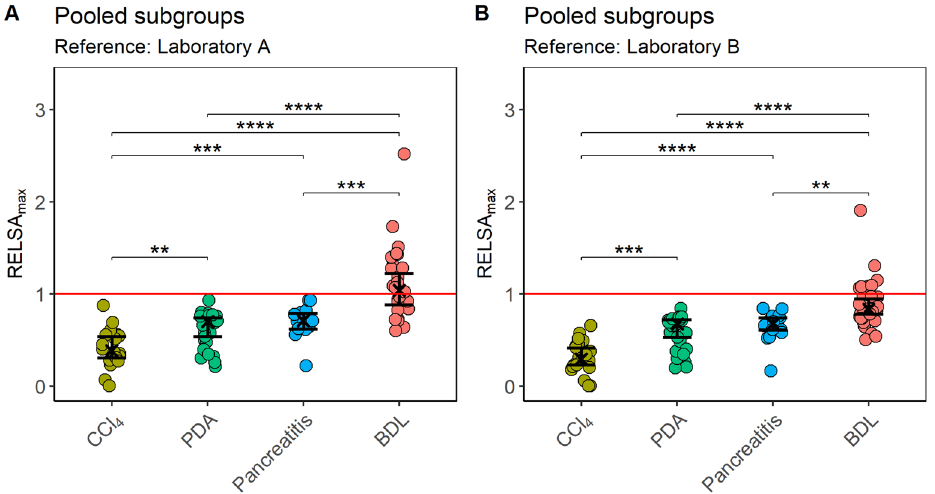
Figure 6. Between-model comparisons of distress after pooling the experimental subgroups. ( A ) The distress of the carbon tetrachloride (CCl 4 ), pancreatitis (Panc), pancreatic cancer (PDA), and the cholestasis (BDL) model was evaluated using the RELSA max values, with the reference built from data of laboratory A (transmitter implantation model, measured variables: body weight, burrowing activity as well as the distress score, the red line denotes the maximally experienced severity in the telemetry experiment). A Kruskal–Wallis test shows significant differences between the RELSA max estimates of the animal models in panel ( A ) ( χ 2 = 54.86, df = 3, p < 0.0001). Differences were observed between CCl 4 and PDA (**p adj < 0.01), CCl 4 and BDL (****p adj < 0.0001), pancreatitis and BDL (***p adj < 0.001) as well as between PDA and BDL (****p adj < 0.0001). The following order (cid:31) (cid:31) R CCl R PDA of model severity can be seen by ordering the RELSA max estimates: = 0.40, CI 95% [0.29; 0.52]) < PDA ( 4 (cid:31) (cid:31) R Panc = 0.70, CI R BDL = 1.10, CI = 0.61, CI 95% [0.50; 0.71]) < Pancreatitis ( 95% [0.56; 0.83]) < BDL ( 95% [1.00; 1.20]). ( B ) Testing the robustness of the procedure by implementing a different reference set from laboratory B with the variables body weight and burrowing activity. The treatment groups also showed significant differences using the Kruskal–Wallis test ( χ 2 = 53.15, df = 3, p < 0.0001). Pairwise differences were observed between CCl 4 and PDA (***p adj < 0.001), CCl 4 and Pancreatitis (****p adj < 0.0001), CCl 4 and BDL (****p adj < 0.0001), Pancreatitis and BDL (**p adj < 0.01) as well as between PDA and BDL (****p adj < 0.0001). Here, the order of RELSA max estimates (cid:31) (cid:31) (cid:31) R Panc = R CCl R PDA = 0.58, CI showed as follows: = 0.31, CI 95% [0.22; 0.40]) < PDA ( 95% [0.50; 0.67]) < Pancreatitis ( 4 (cid:31) R BDL = 0.89, CI 0.65, CI 95% [0.54; 0.76]) < BDL ( 95% [0.81; 0.96]). The graphs depict the RELSA max values obtained from individual RELSA analyses (pooled subgroups for each animal model) and the bootstrapped